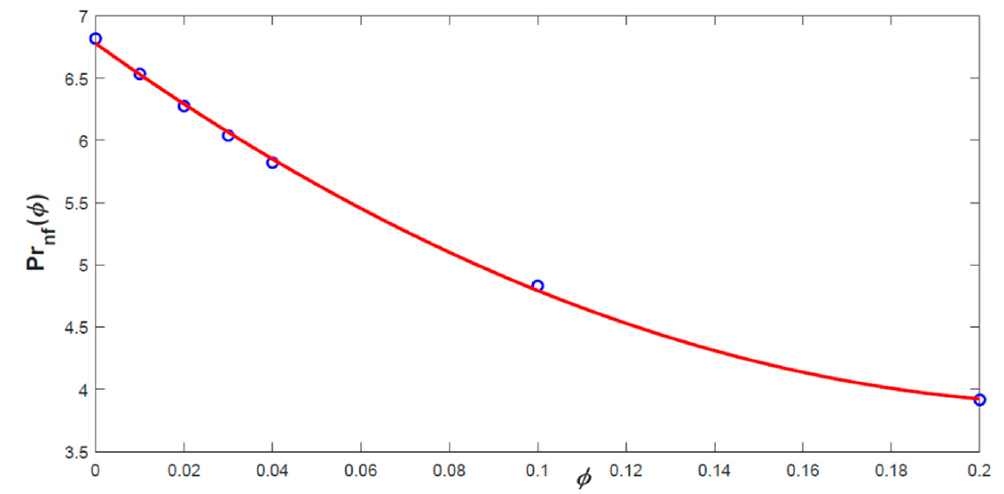
Figure 1. Variation of Pr nf with φ for Fe 3 O 4